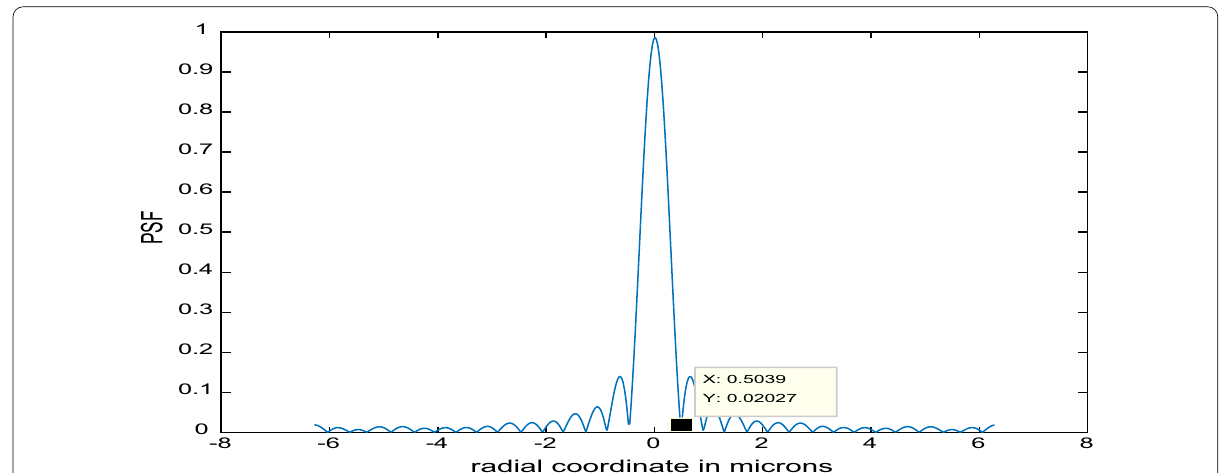
Fig. 9 The PSF using uniform circular aperture of radius